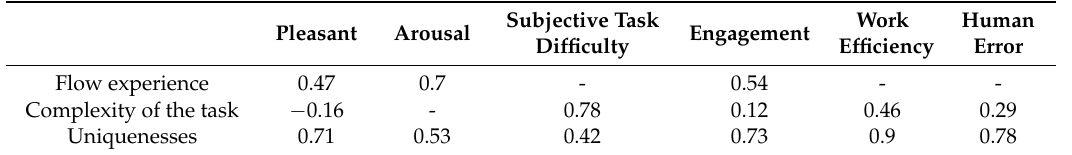
Table A4. The result of factor